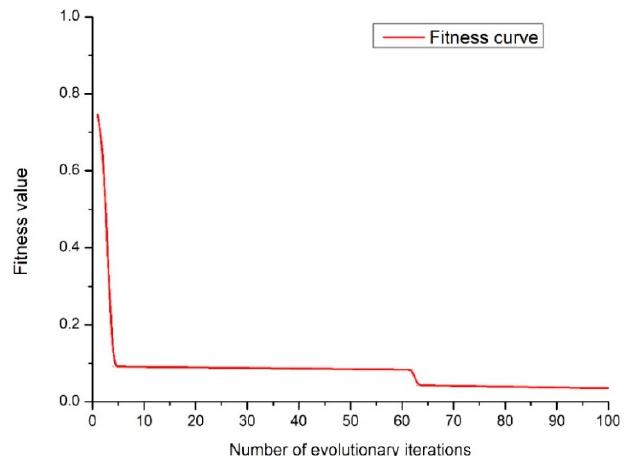
Figure 11. GA optimized fitness curves.